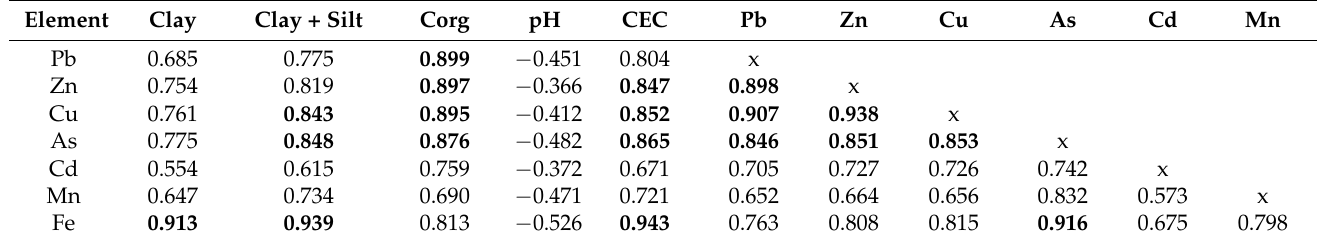
Table 4. Single Spearman correlation coefficients between the main parameters of soil properties and concentrations of metal(loid)s. All the correlations proved significant at the level of 99.9% ( p < 0.001). Particularly high values of coefficient (>0.840) have been highlighted in bold.